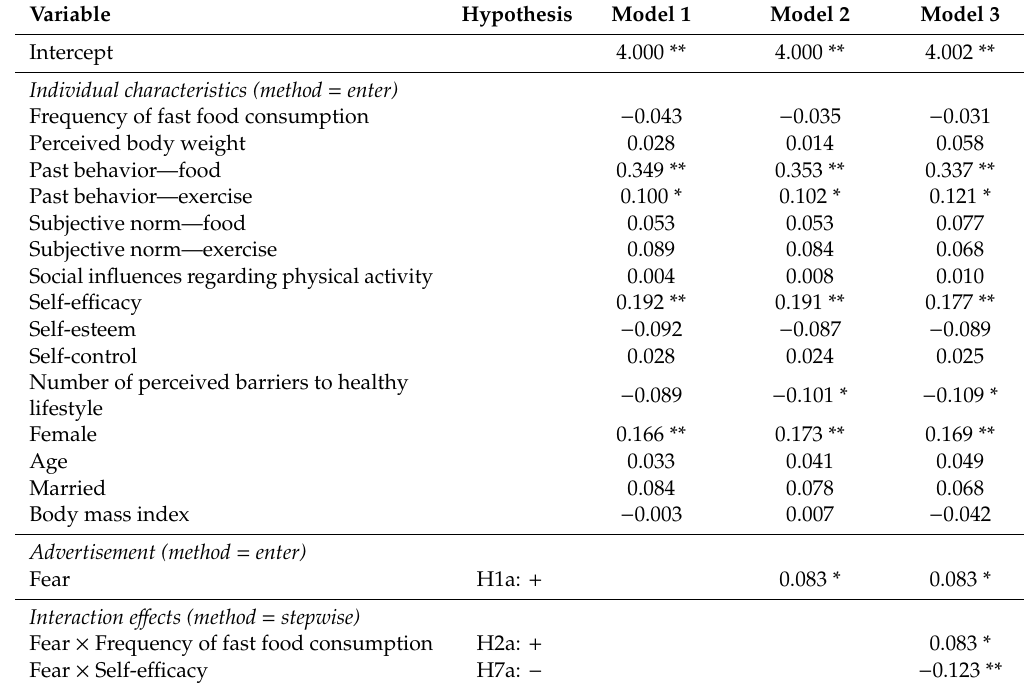
Table 3. Hierarchical linear regression predicting healthy eating